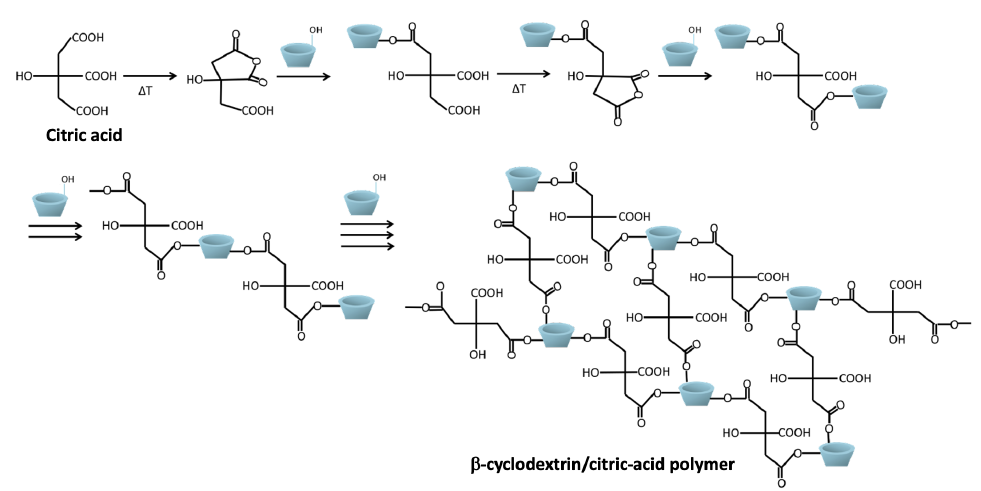
Figure 4. Polyesterification reaction between citric acid and β -cyclodextrin for the formation of the cross-linked